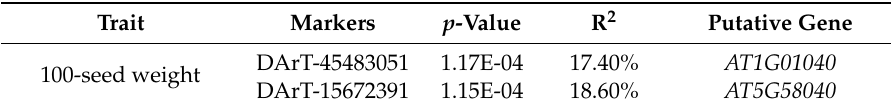
Table 5. Marker-trait associations of the 100-seed weight with its associated markers in international sa ffl ower panel of 94